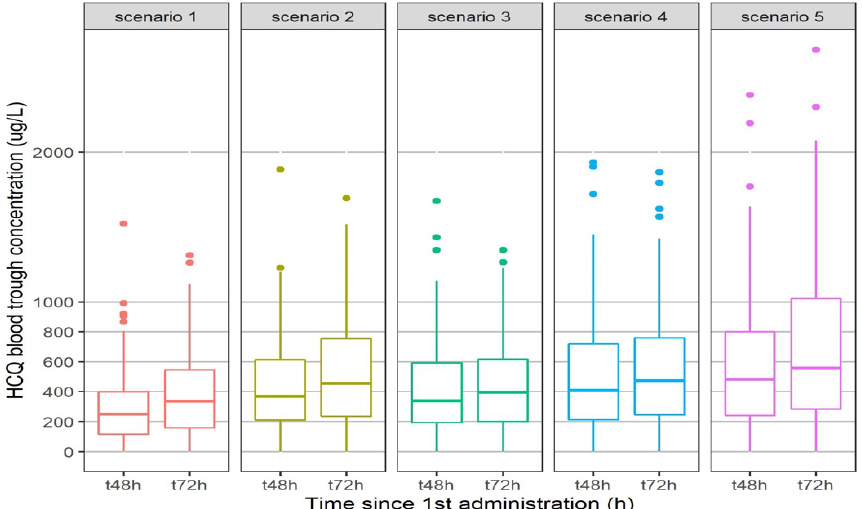
Figure 8. Simulation of HCQ trough concentrations at t48 h and t72 h according to different regimen. Scenario 1:200 mg bid; Scenario 2:200 mg tid; Scenario 3:400 mg bid on Day 1 followed by 200 mg bid; Scenario 4:400 mg bid on Day 1 followed by 200 mg tid; Scenario 5:400 mg bid.